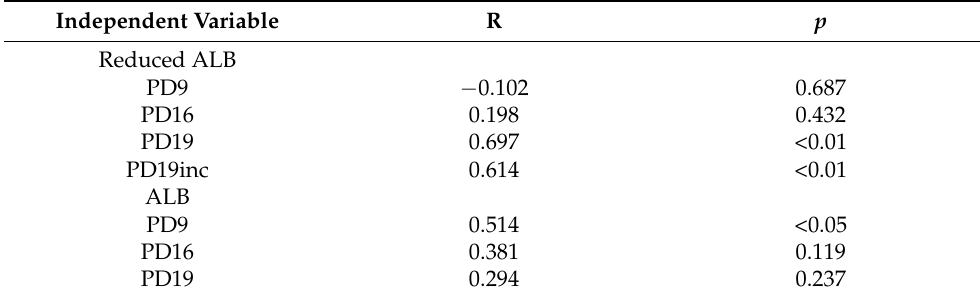
Table 4. Simple linear regression analyses of serum reduced albumin (ALB) ratio and serum ALB concentration vs. birth weight in the litter in pregnant rats *1